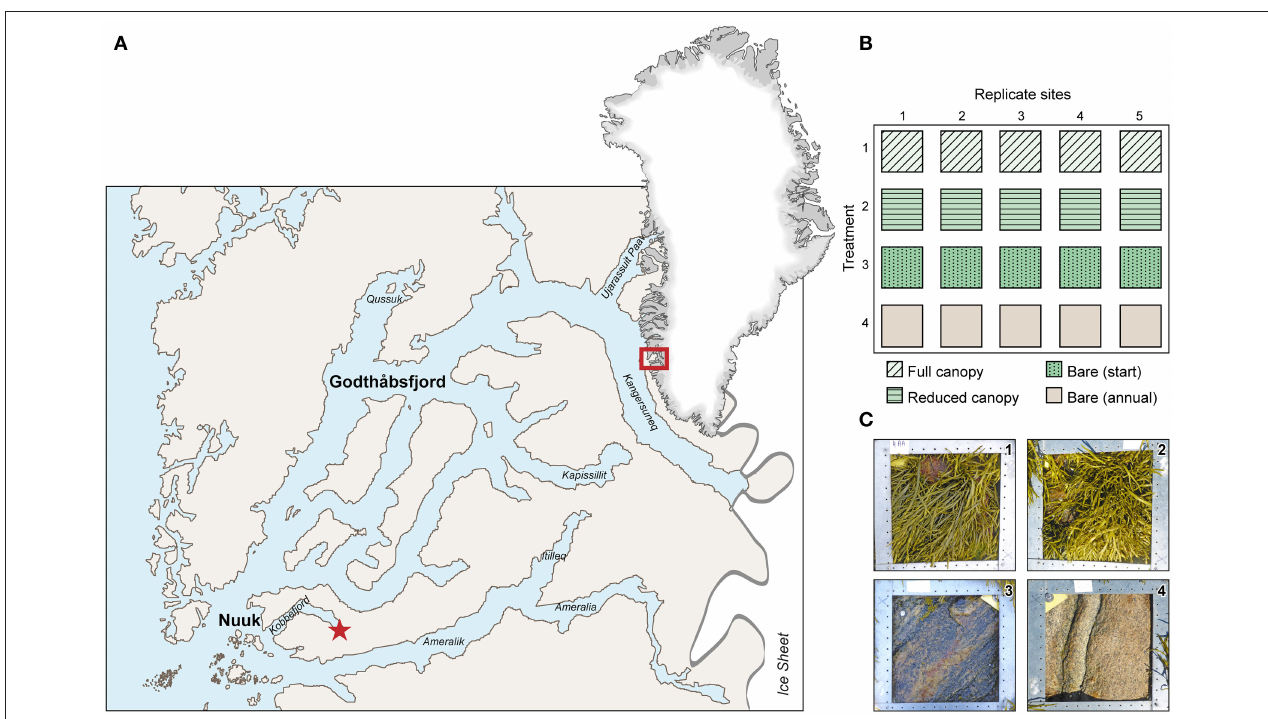
FIGURE 1 | Study area and experimental setup. (A) Godthåbsfjord system, SW Greenland with indication of the study site in inner Kobbefjord ( 64 ◦ 08N, 51 ◦ 23W). (B) Experimental setup applied in inner Kobbefjord mid intertidal, with the four treatments applied at each of the five replicate sites. (C) Examples of experimental quadrats from each treatment by August 2014 (the end of experimental period) [1: Full canopy, 2: Reduced canopy, 3: Bare (start), 4: Bare (annual) ( Table 1